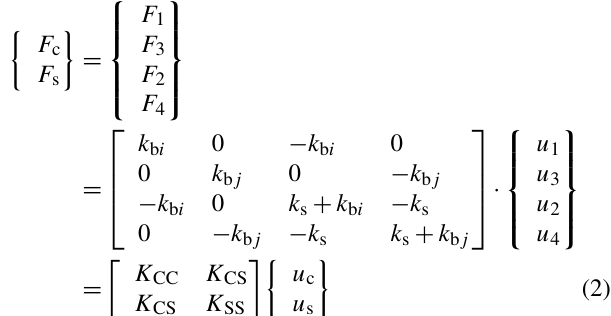
tion (cid:49)u c ( x ) = P